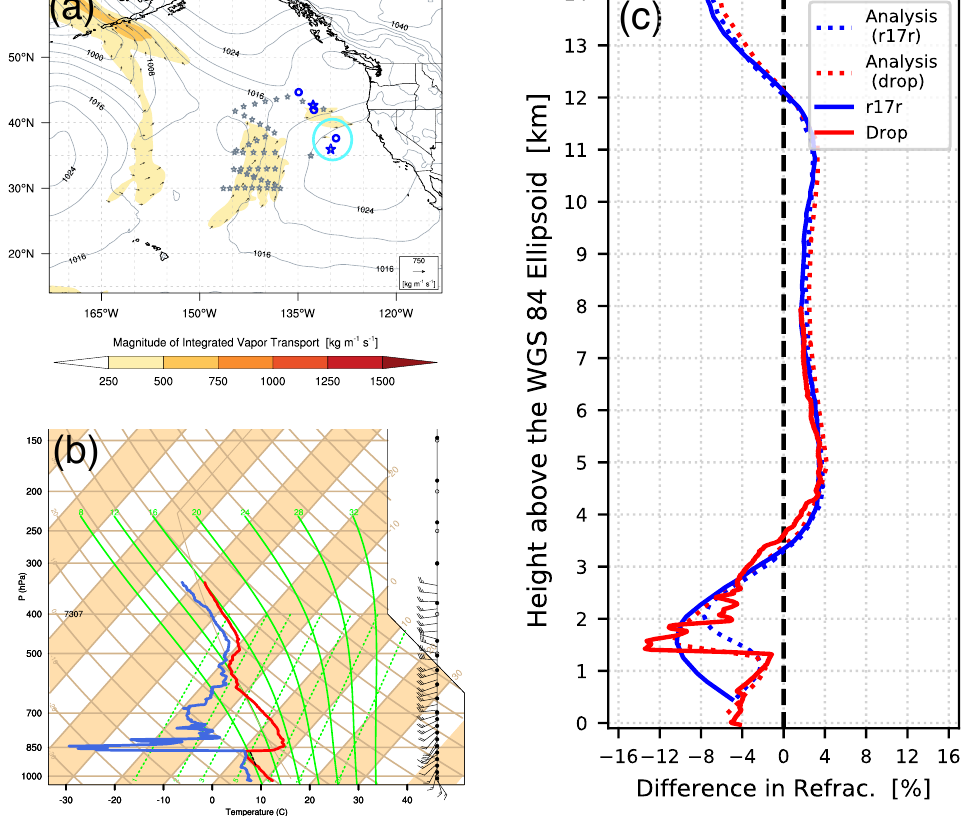
Figure 3. Same as Figure 2 but for an example occultation from the Spire dataset (blue) that approxi- mately 200 km apart in space and approximately 40 min apart in time during the fourth intensive observing period (IOP04) of AR Recon